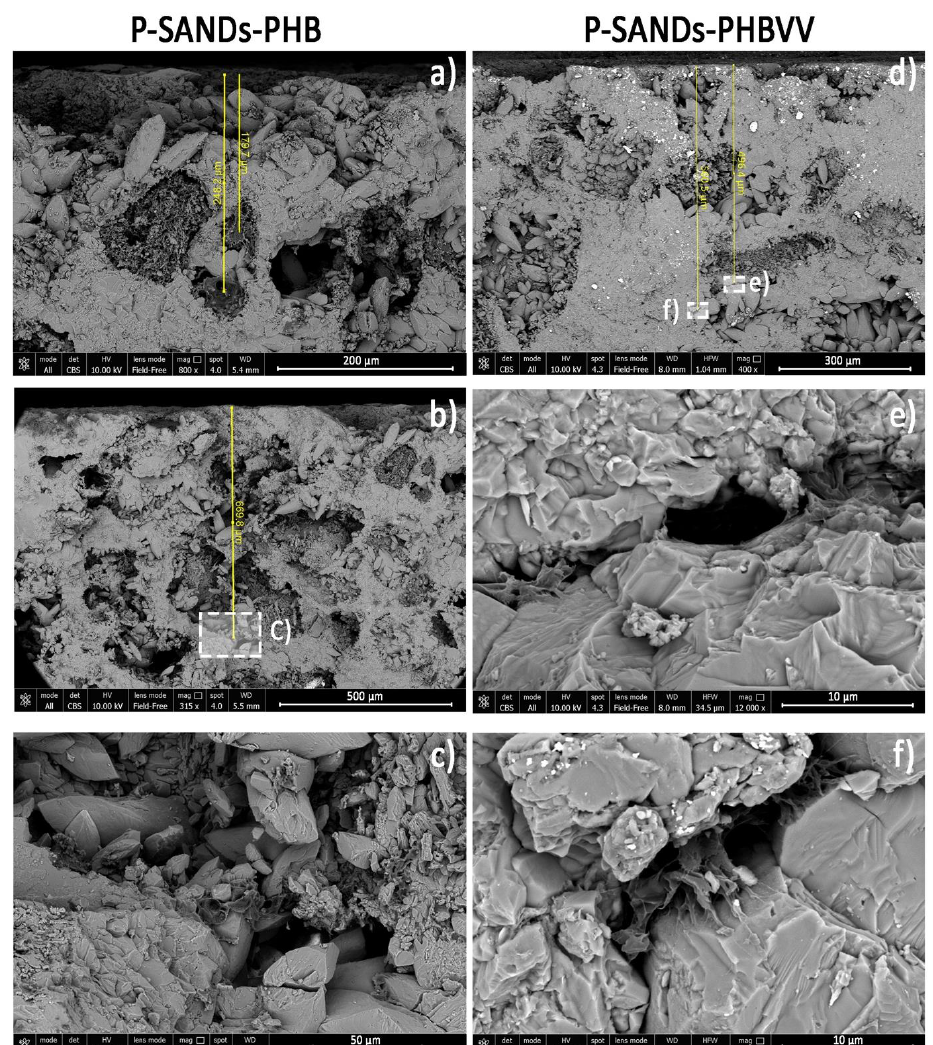
Figure 8. FEG-SEM images of sandstone treated: ( a – c ) with PHB-based formulation by poultice; ( d – f ) with PHBVV-based formulation by poultice.